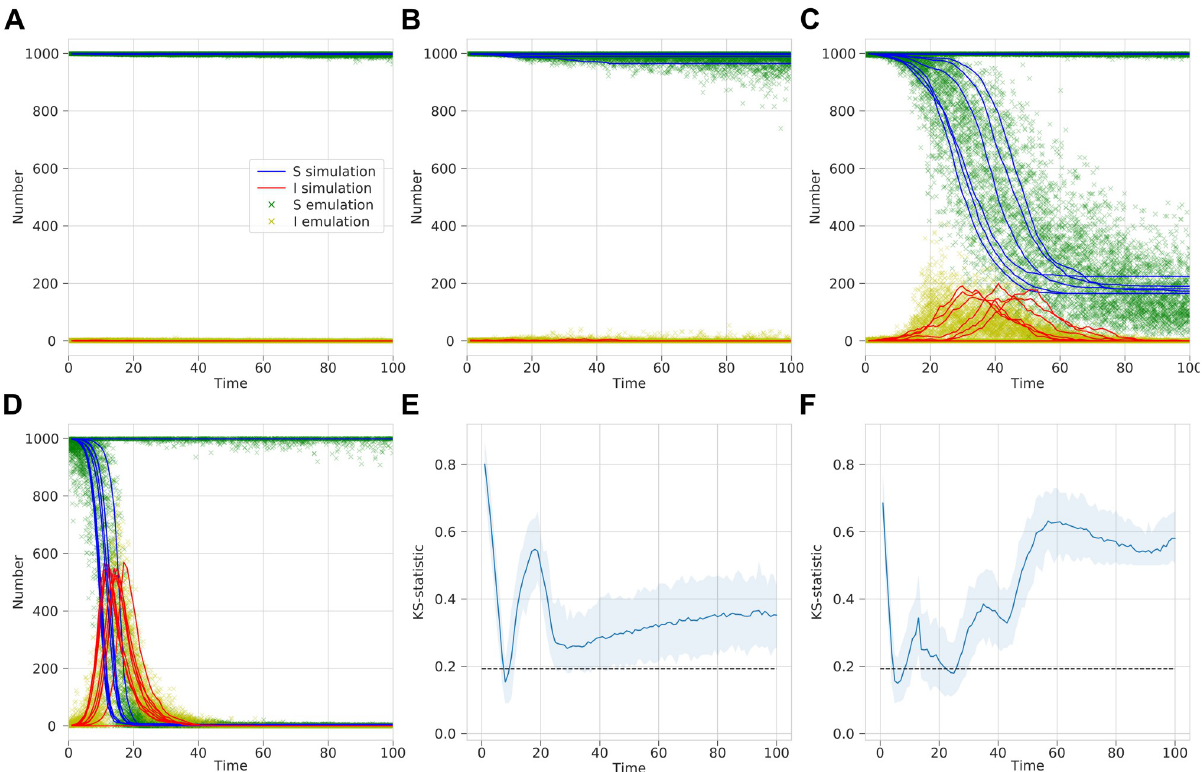
Fig 4. Beta-MDN output emulating the infection dynamics with time for a stochastic SIR model. (A–D) A comparison of simulation results with sampled MDN output for fixed γ = 0.2 and N = 1, 000 and different β values that give the following R 0 values: (A) R 0 = 0.5, (B) R 0 = 1.0, (C) R 0 = 2.0, and (D) R 0 = 5.0. (E–F) Two-sample K–S statistic where sample of 100 points are drawn from a negative binomial and the MDN over a range of time t values. 100 replicates are used to estimate a mean K–S statistic and a 95% range. Dashed line represent significance at α = 0.05, with values less indicating the two samples do not differ significantly. Tests are for (E) number of susceptible people and (F) number of infected